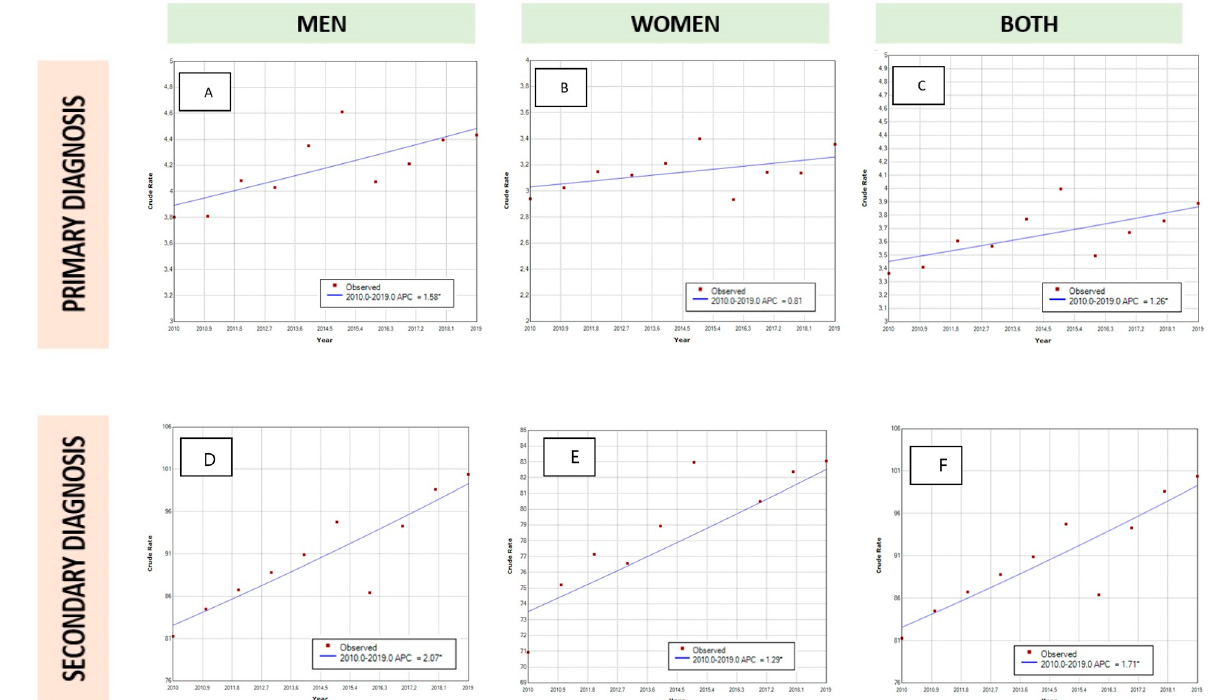
Figure 1. Joinpoint analysis with Annual Percent Change (APC) in PD as a primary diagnosis in men ( A ), women ( B ) and both sexes ( C ). Annual Percent Change (APC) in PD as a secondary diagnosis in men ( D ), women ( E ) and both sexes ( F ). * Indicates that the APC is significantly different from zero at the alpha = 0.05 level.